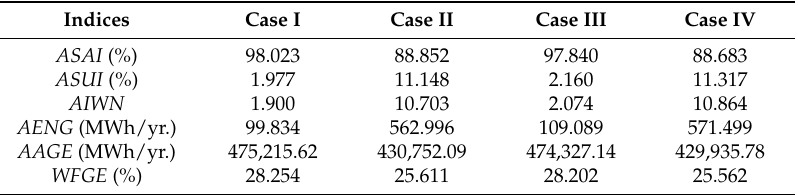
Table 6. Reliability indices of the wind farm electrical